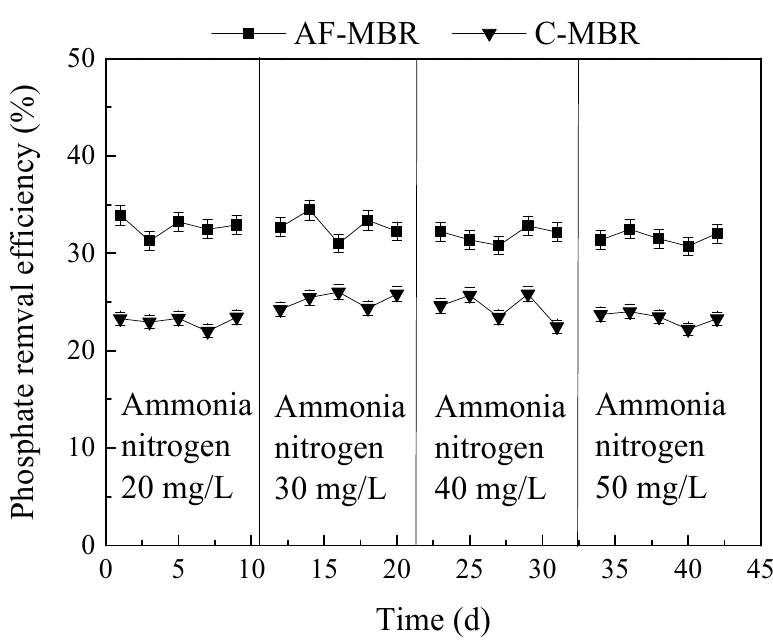
Figure 9. Influence of different ammonia nitrogen loads on phosphate removal efficiency.